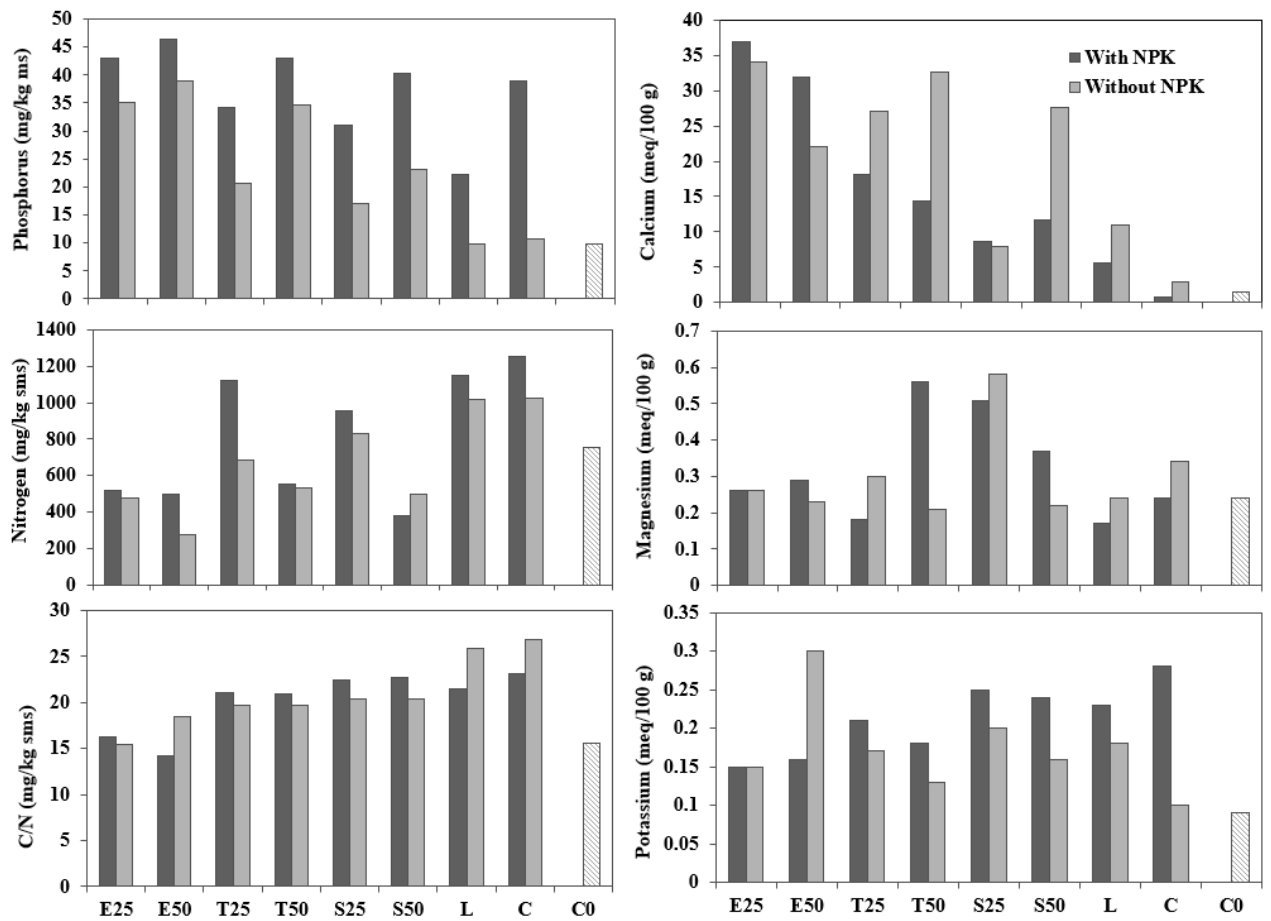
Figure 5. Macronutrient concentration and soil parameters in comparison with initial soil charac- teristics (C0).